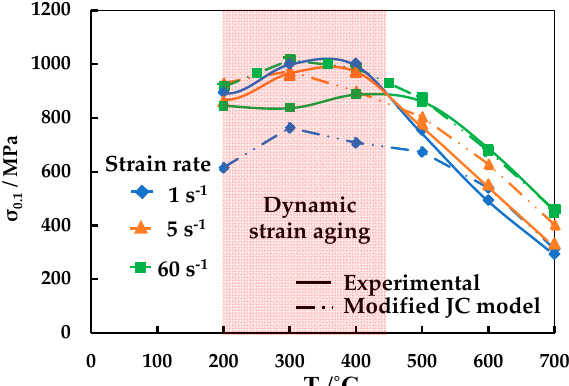
Figure 7. Flow stress at a true plastic strain of 0.1 versus temperature modeled using the modified J-C model.